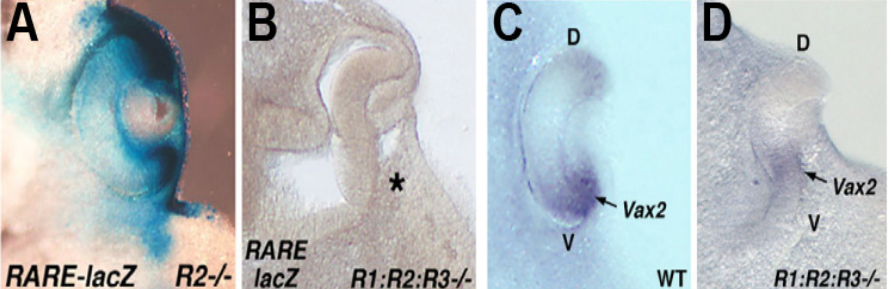
Figure 2. RA signaling is required during optic cup formation. ( A ) RA activity, detected by the RARE-lacZ transgene, and optic cup formation are both normal in E10.5 RA-rescued Aldh1a2 -/- single knockout embryos ( R2 -/-); Aldh1a2 -/- embryos do not develop beyond E8.5, but a single low-dose maternal treatment with exogenous RA at E7.5 results in growth to E10.5 and clearance of exogenous RA by E9.5 [25]; RA activity observed at E10.5 is due to expression of Aldh1a1 and Aldh1a3 in the optic vesicle [18]. ( B ) For E10.5 RA-rescued triple knockout embryos ( R1:R2:R3 -/-) one observes a lack of RA activity and a failure to form the optic cup; *, failure of ventral invagination of optic vesicle. ( C , D ) Another triple knockout ( R1:R2:R3 -/-) compared to wild type (WT) stained for Vax2 mRNA (a marker of the ventral retina) also shows a failure in optic cup formation primarily due to a failure in ventral invagination of the optic vesicle. Shown are dorsoventral sections; adapted from [18]. Subsequent to these mouse genetic loss-of-function studies, not much progress has been made on the mechanism through which RA controls optic cup formation. No direct RA target genes have been identified in the optic vesicle due to the difficulty of obtaining Aldh1a1/Aldh1a2/Aldh1a3 triple knockouts [18]. Fortunately, RDH10 was found to be the only retinol dehydrogenase for the first step of RA synthesis in the eye (conversion of retinol to retinaldehyde); Rdh10 -/- embryos survive to E10.5, have no RA activity detected in the optic field, and fail to undergo optic cup formation with loss of ventral invagination [2], similar to that observed in Aldh1a1/Aldh1a2/Aldh1a3 triple knockouts. Further studies on Rdh10 -/- embryos should allow progress to be made on the mechanism through which RA controls optic cup